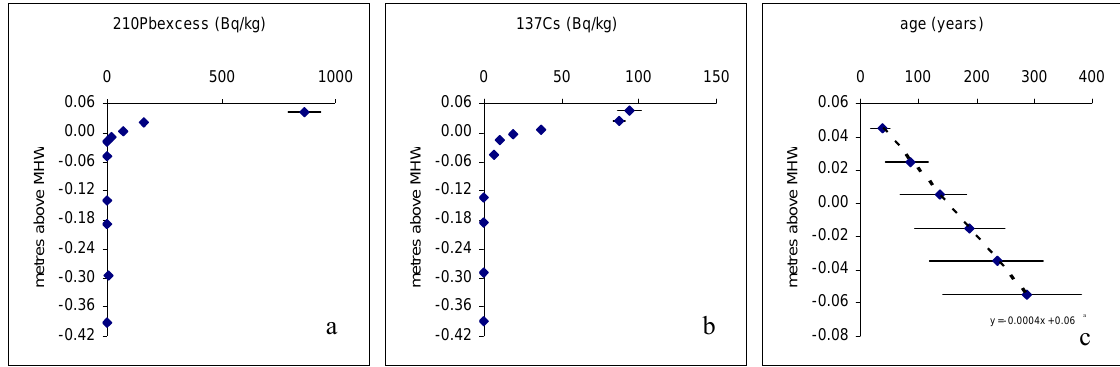
Fig. 9. Results of radiometric dating in core 4, Aliki: variation of 210 Pb (a) and 137 Cs (b) with depth and the sediment accumulation rate (age-depth curve) based on the simple model of 210 Pb dating (c)